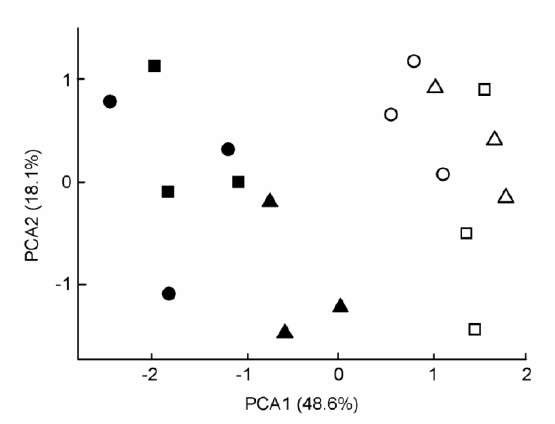
Figure 2. Principal component biplot of the elemental concentrations of leaves. Notations: = Ficus religiosa from industrial, = F. religiosa from urban, = F. religiosa from rural, = Mimusops elengi from industrial, = M. elengi from urban, = M. elengi from rural site. Table 1. Mean ± standard error of elemental concentration (mean ± SE) of leaves in Thailand. Elements